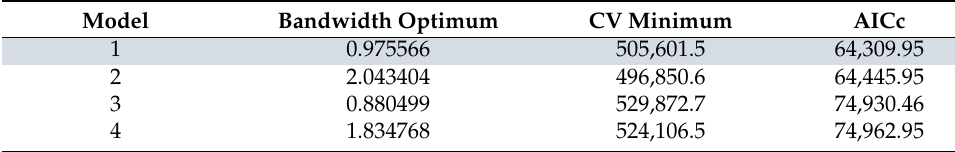
Table 4. Bandwidth optimum, CV minimum and AICc for each model.